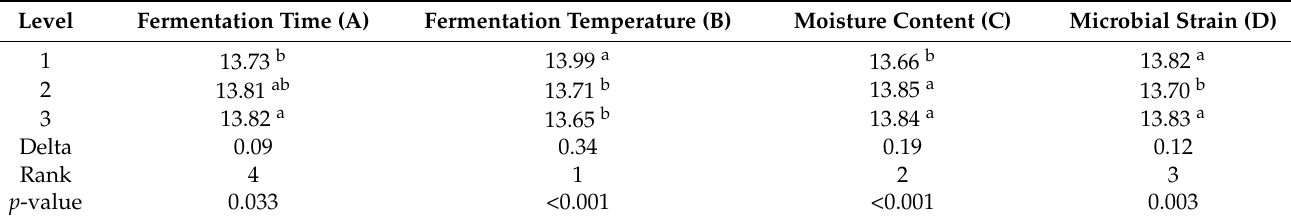
Table 4. Effects of different factor levels on CP of TMR with RSM.